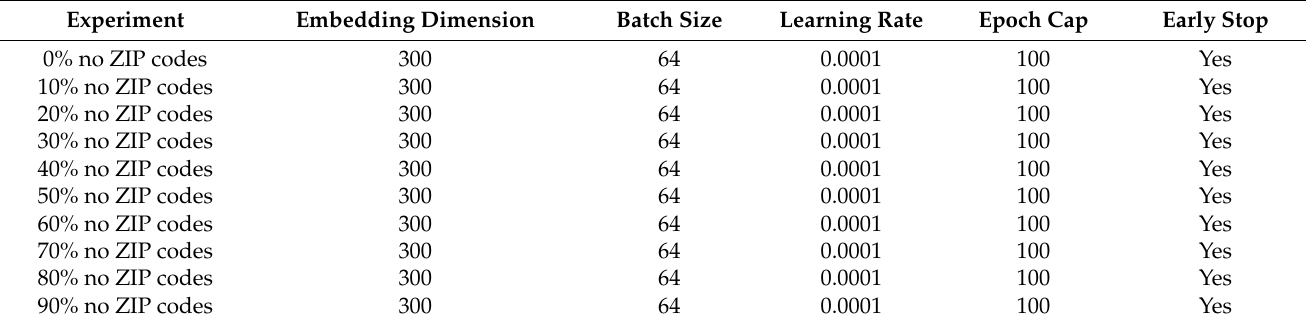
Table A5. Hyperparameters settings for the LSTM.